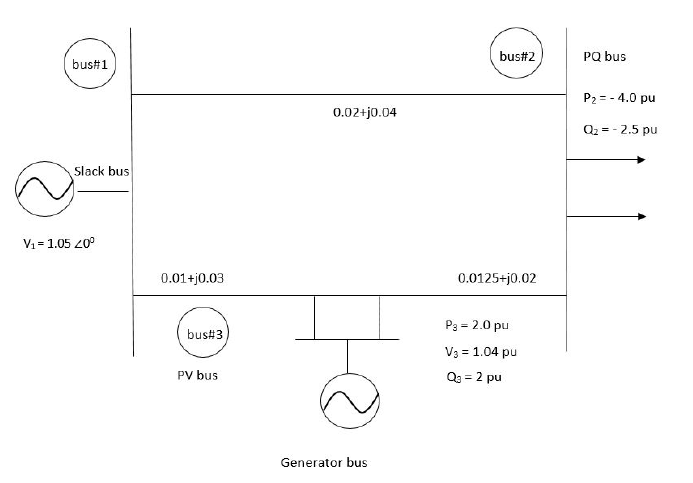
Figure 4. Power System.